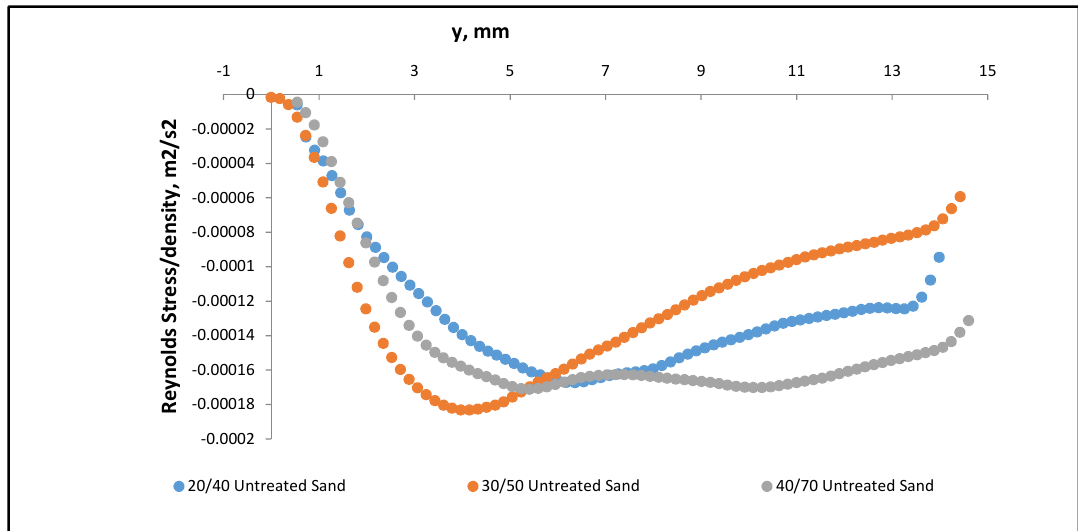
Figure 7. Near-wall (dimensionless) velocity profiles for the flow of the polymer fluid over the sand bed at a superficial velocity of 0.25 m / s.